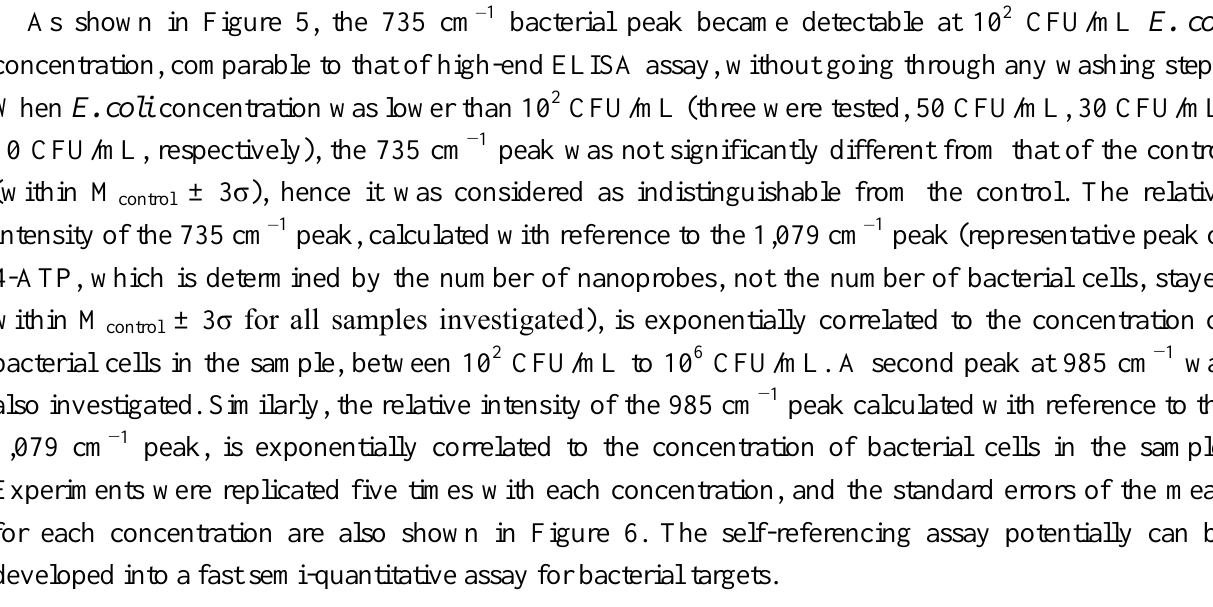
Figure 6. The correlation between the relative Raman intensity of the 735 cm –1 peak and the concentration of E. coli cells in the sample. The relative Raman intensity was calculated using the 4-ATP peak at 1,079 cm –1 as internal reference, error bar indicates the standard errors of the mean from five independent